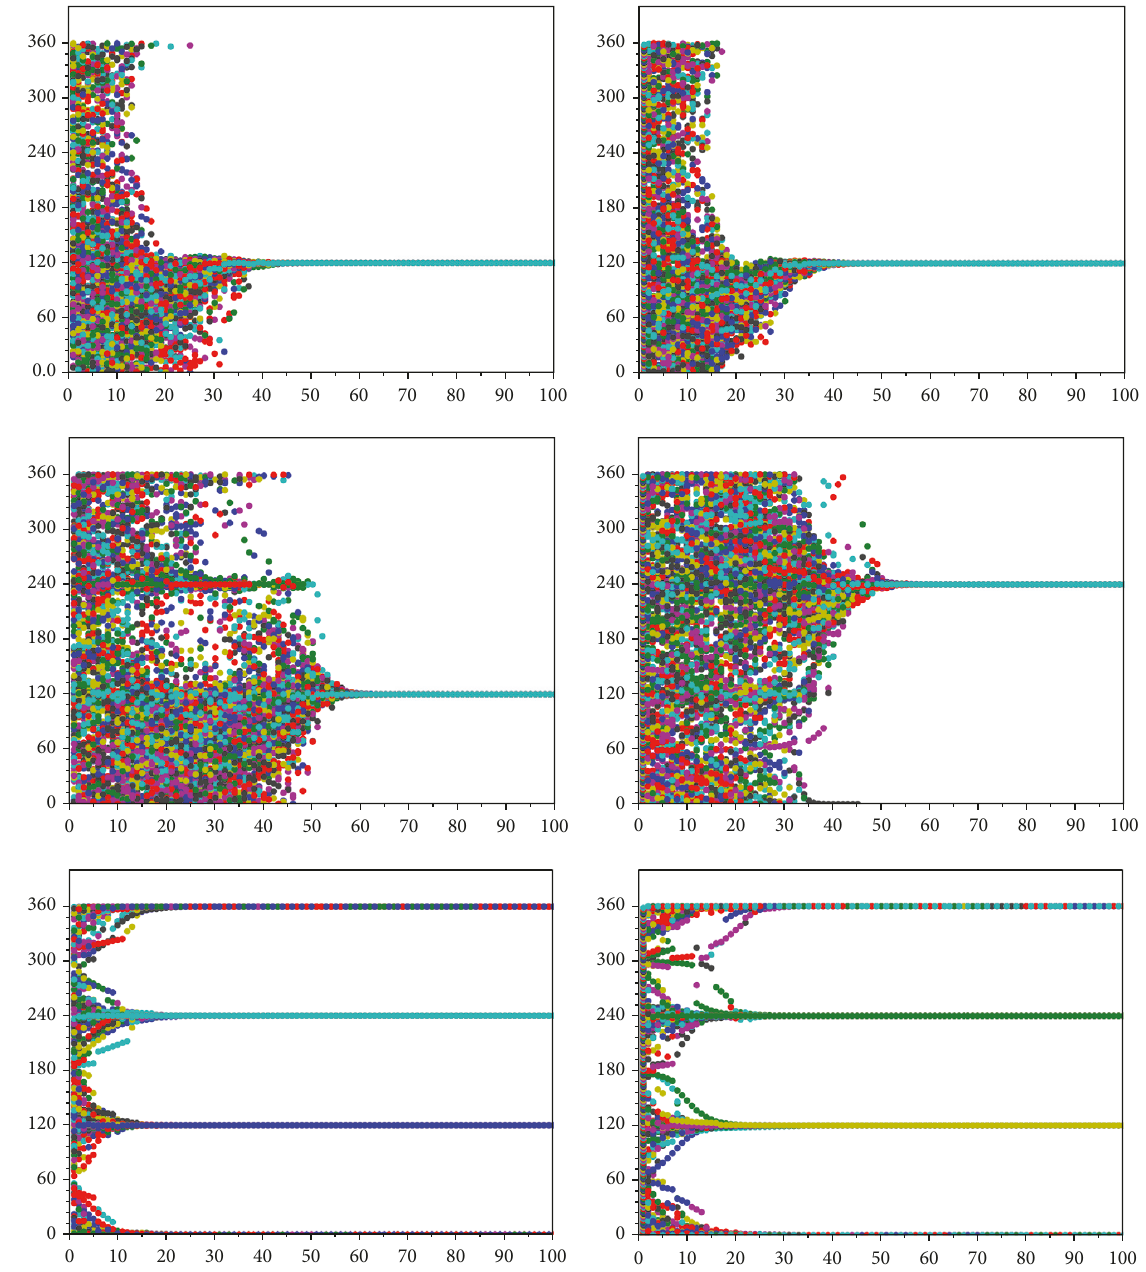
Figure 2: The confidence bounds are 𝜖 = 180 ∘ (top row); 𝜖 = 120 ∘ (middle row), and 𝜖 = 60 (bottom row). 𝜅 𝑖 ∈ [0.5 ∘ , 38 ∘ ] . Function 𝑔 1 (𝑥) is used on left column and 𝑔 2 (𝑥) on the right. In the top row, a single cluster appears. In the middle row, initially two clusters appear, which finally merge. In the lower row, three clusters, with about one-third of the population, appear. Strong consensus appears always, in all three cases, according to Theorem